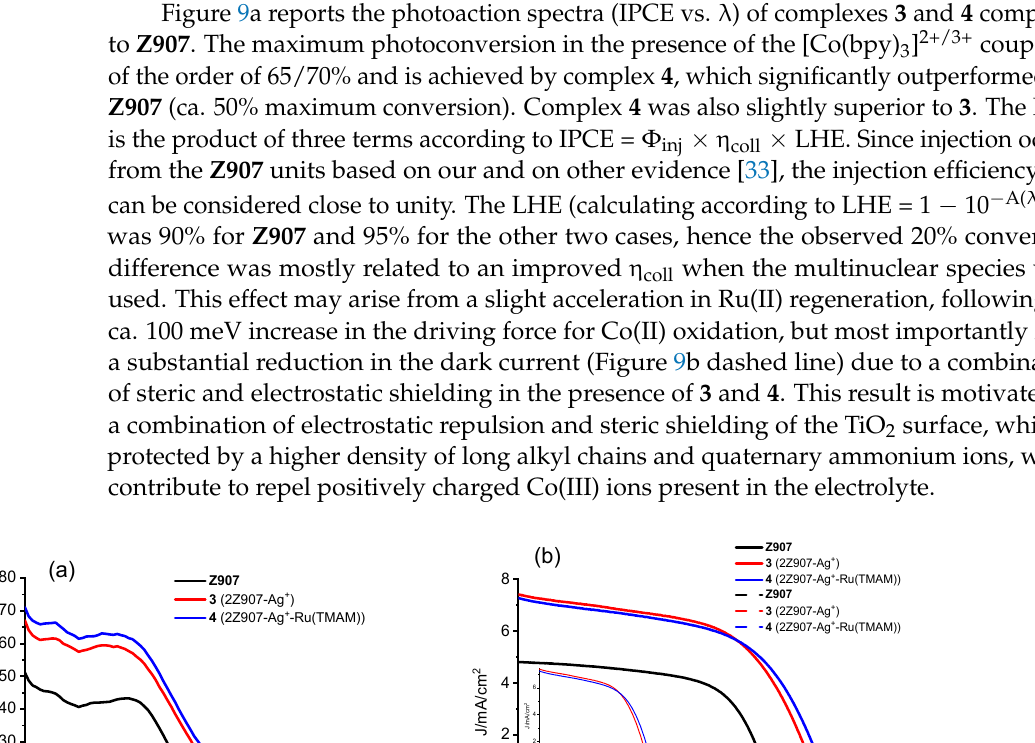
Figure 8. TAS recorded on TiO 2 for ( a ) 3 (2Z907-Ag + ) and for ( b ) 4 (2Z907-Ag + -Ru(TMAM)). Thin films are in contact with 0.1 M Li + in CAN.